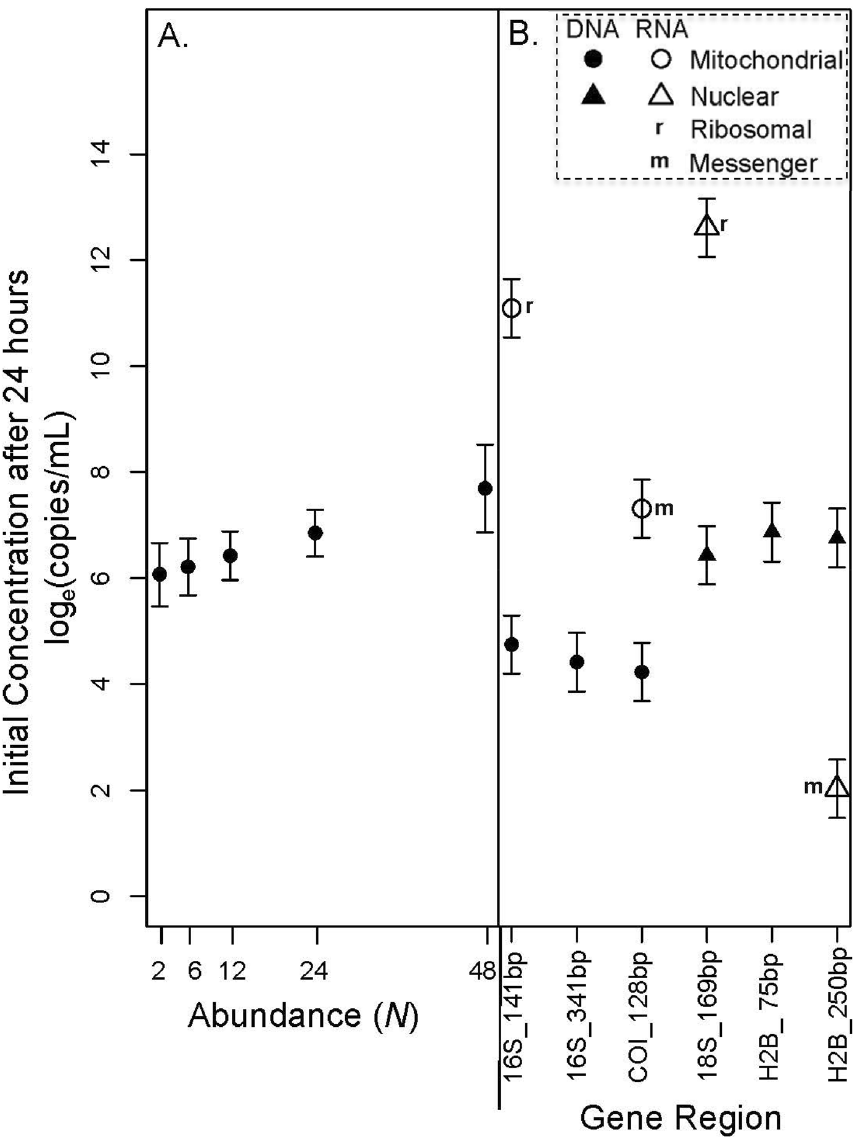
Figure 2. Shedding concentration log e (copies/mL) released after 24 h analyzed across ( A ) mussel abundance with all genetic markers combined, and ( B ) across each of the target gene markers with all abundances combined. Interactions between gene marker and abundance are in the Supplementary Information, including Supplementary Fig. S1. Error bars represent 95% confidence